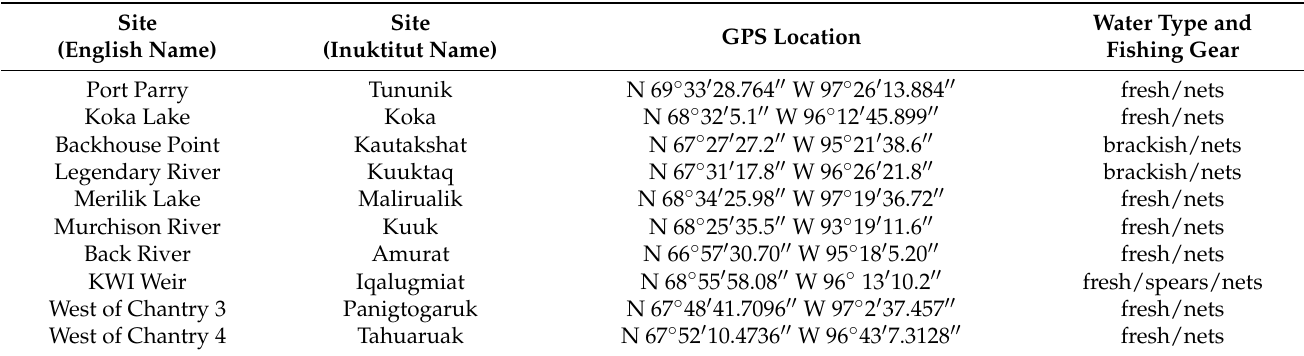
Table 1. Fishing sites sampled in the east Kitikmeot region of Nunavut, Canada, showing names of fishing sites (English and Inuktituk), global positioning system (GPS) coordinates, water type, and fishing gear used. Site (English